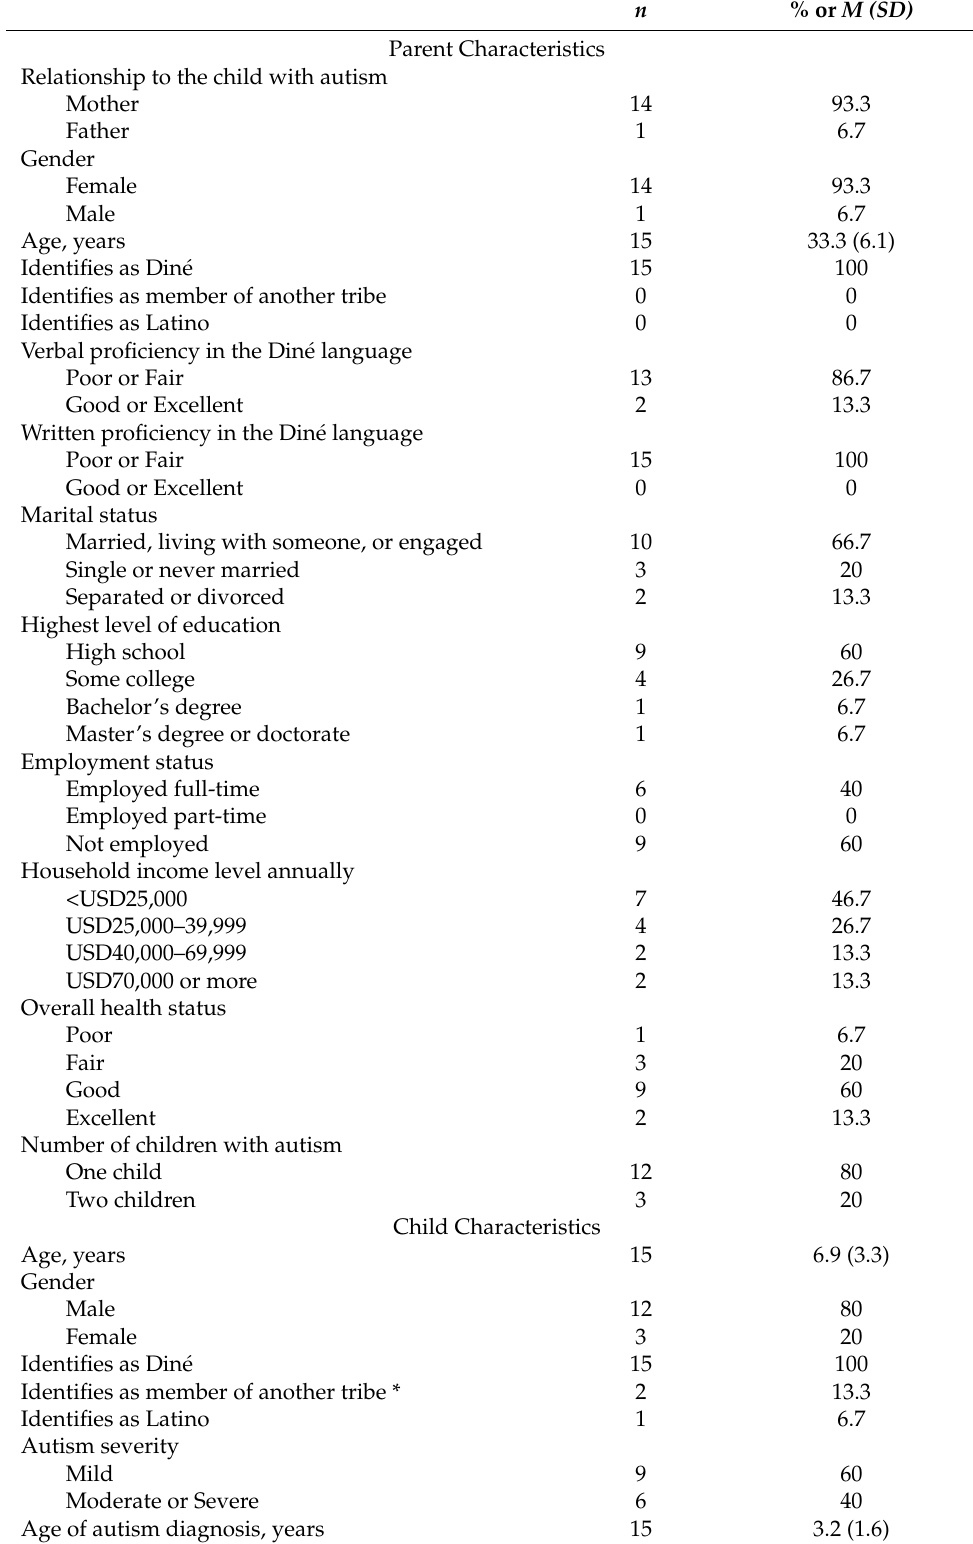
Table 1. Din é Interview Participant